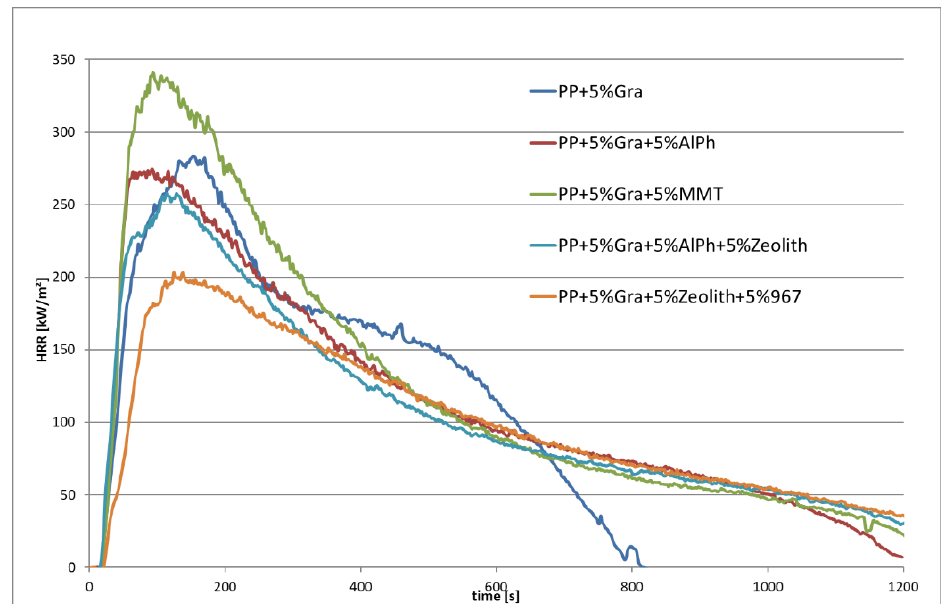
Figure 20. Best materials concerning Heat Release Rate (HRR) and burned length of Schlyter test.